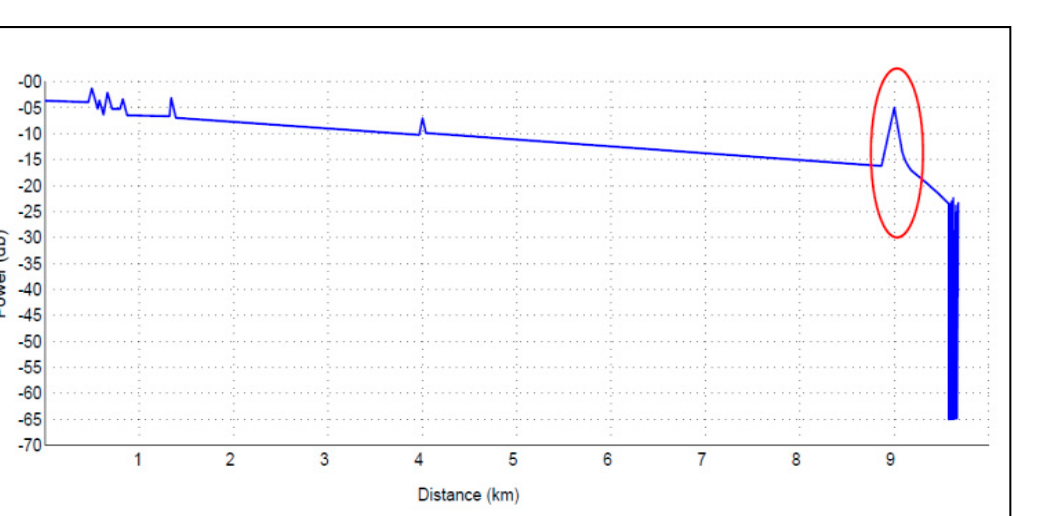
− 4 dB Figure 8. The improving FPMT circuit detected a fiber end-face contamination pattern shape at event 2. Event 3). A fiber end-face burning is produced in the actual implemented network at a distance of 0.45 km and applying an improved FPMT approach integrated with the EDFA board to detect defects. According to the practical data in Figure 9, the reflection